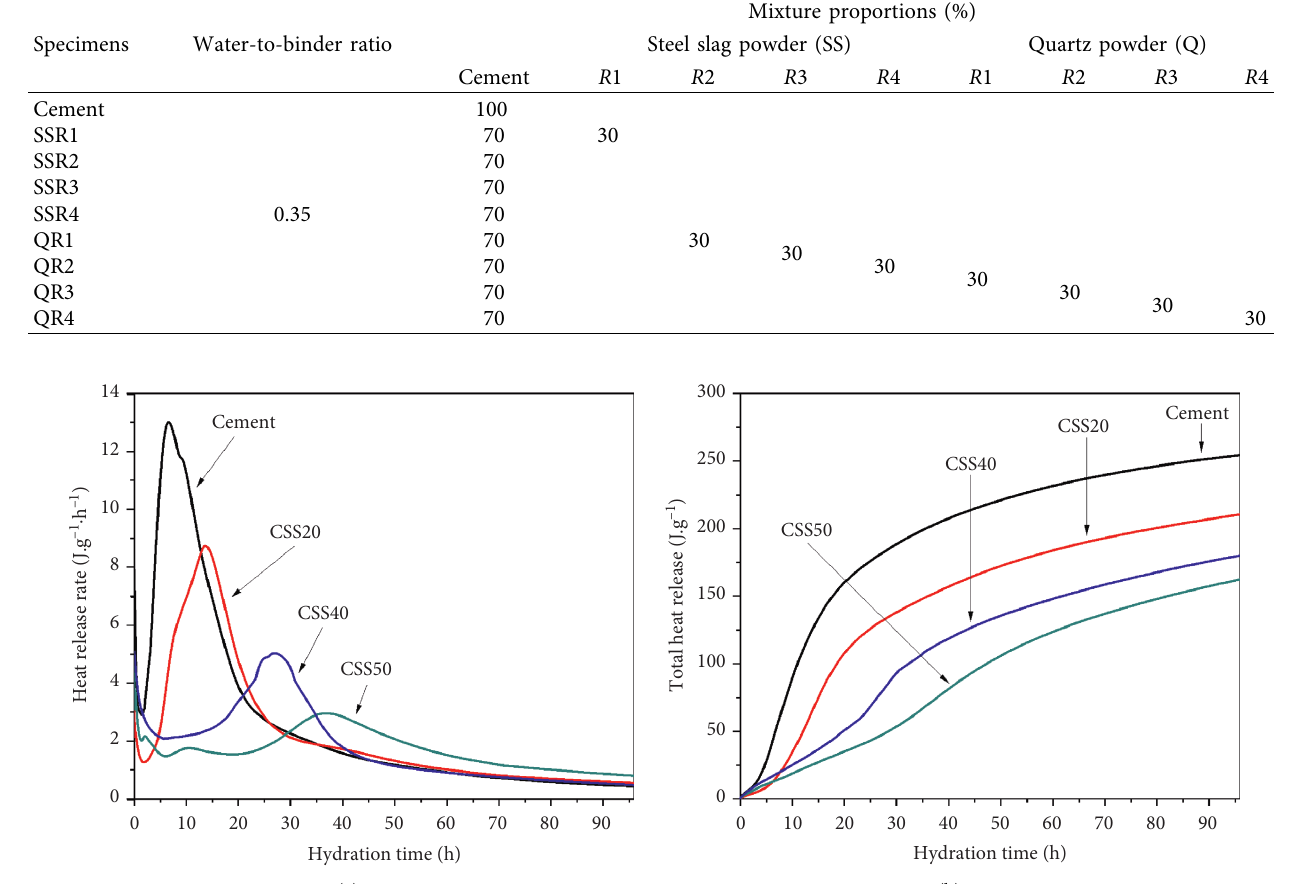
Table 4: Mixing proportions of blended cements containing steel slag powder with different particle